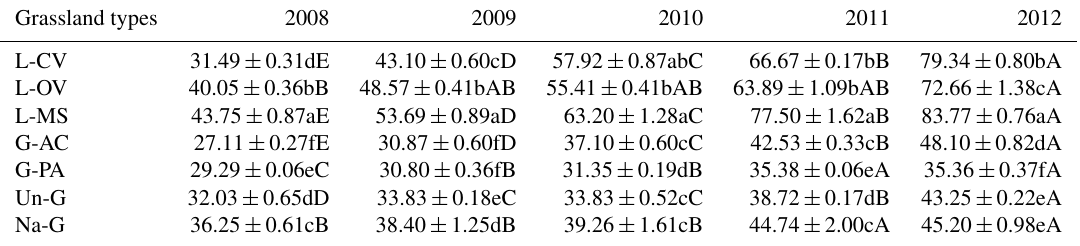
Table 6. SOC stock (M ± SEMgCha − 1 ) at the depth of 0–100cm in different years and grassland types. The grassland types are L-CV, Coronilla varia ; L-OV, Onobrychis viciifolia ; L-MS, Medicago sativa ; G-PA, Poa pratensis ; G-AC, Agropyron cristatum ; Un-G, uncultivated grassland; Na-G, natural grassland. Values followed by different lowercase letters within columns and uppercase letters within rows are significantly different at p